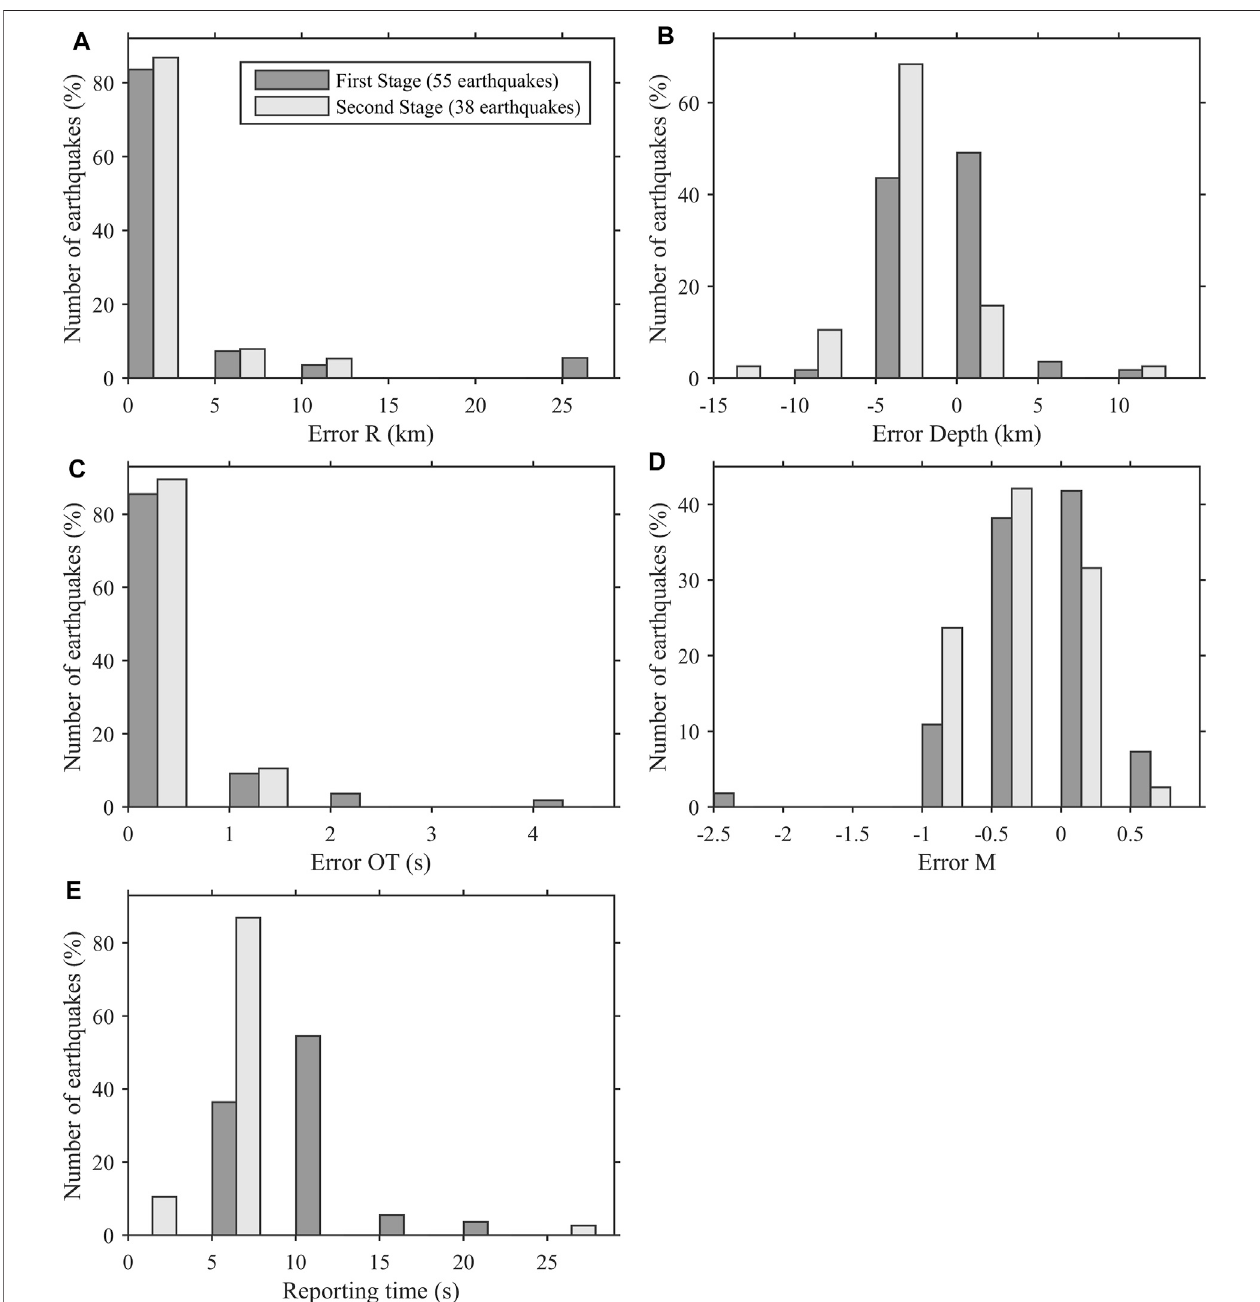
FIGURE 3 | Normalized number of earthquakes (%) vs. deviations between the fi rst alert estimates for the 93 successful alerts output by JEEWS and the China Earthquake Network Center (CENC) catalogs for (A) epicenter, (B) depth, (C) origin time, and (D) magnitude. (E) Normalized number of earthquakes (%) vs. reporting time.ThisisacomparisonofCENCandJEEWSearthquakeparameterestimatesforallChangningeventsstudied,55fromthe fi rststageand38fromthesecondstage.